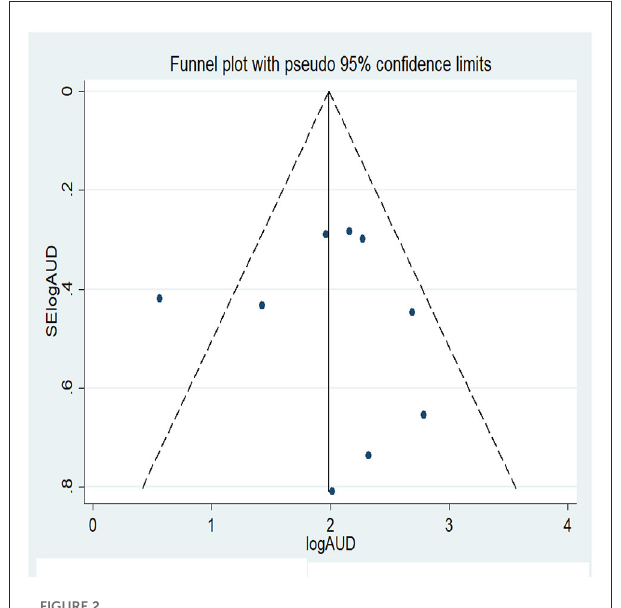
FIGURE2 Funnel plot of publication bias for 1 year prevalence of AUD.